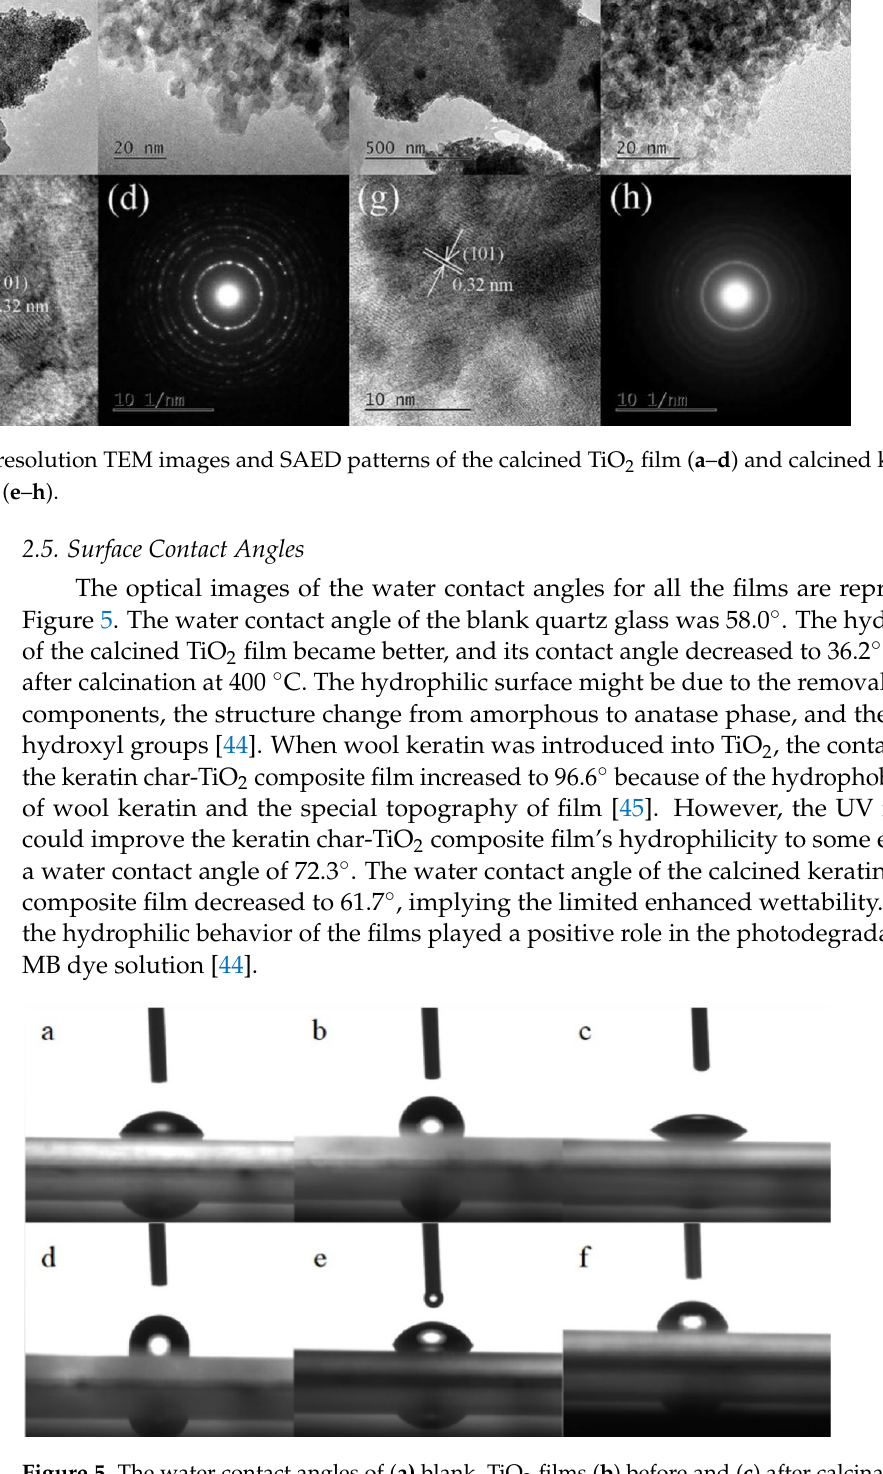
Figure 5. The water contact angles of ( a) blank, TiO 2 films ( b ) before and ( c ) after calcination, keratin char-TiO 2 composite films ( d ) before and ( e ) after calcination, and ( f ) uncalcined keratin char-TiO 2 composite film exposure to UV rays.